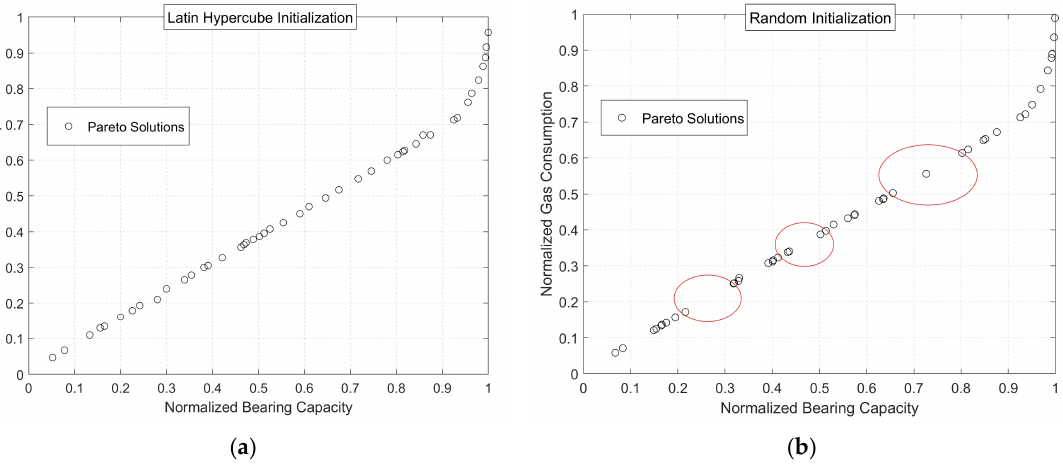
Figure 12. Pareto solutions obtained using ( a ) Latin hypercube and ( b ) random initialization after the 60th generation.